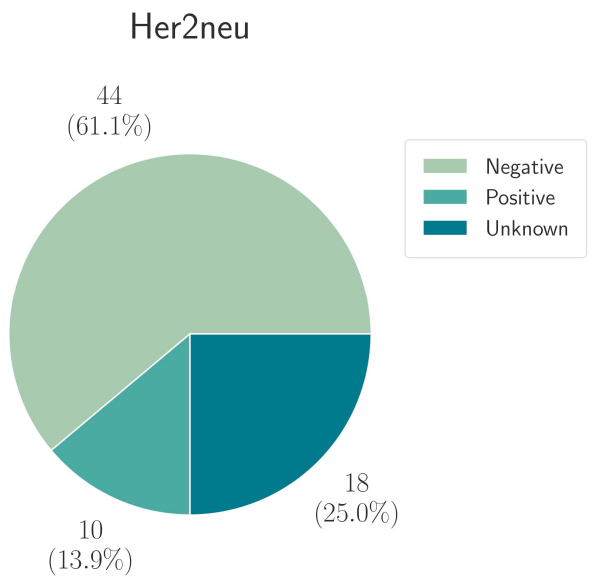
Figure 2. The distribution of patients according to TMB scores ( n = 64). The TMB scores were divided into low, intermediate and high. The classification is based on mutations/mega base according to the FMI CDx test classification.